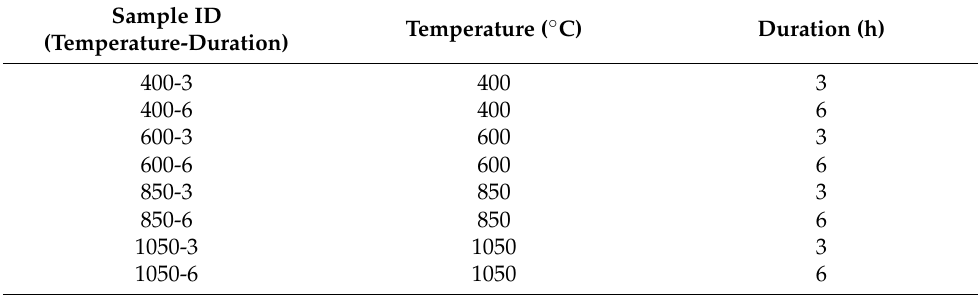
Table 3. Heat treatment of cold sprayed IN625 coating on grey cast iron (GJL250) substrate.